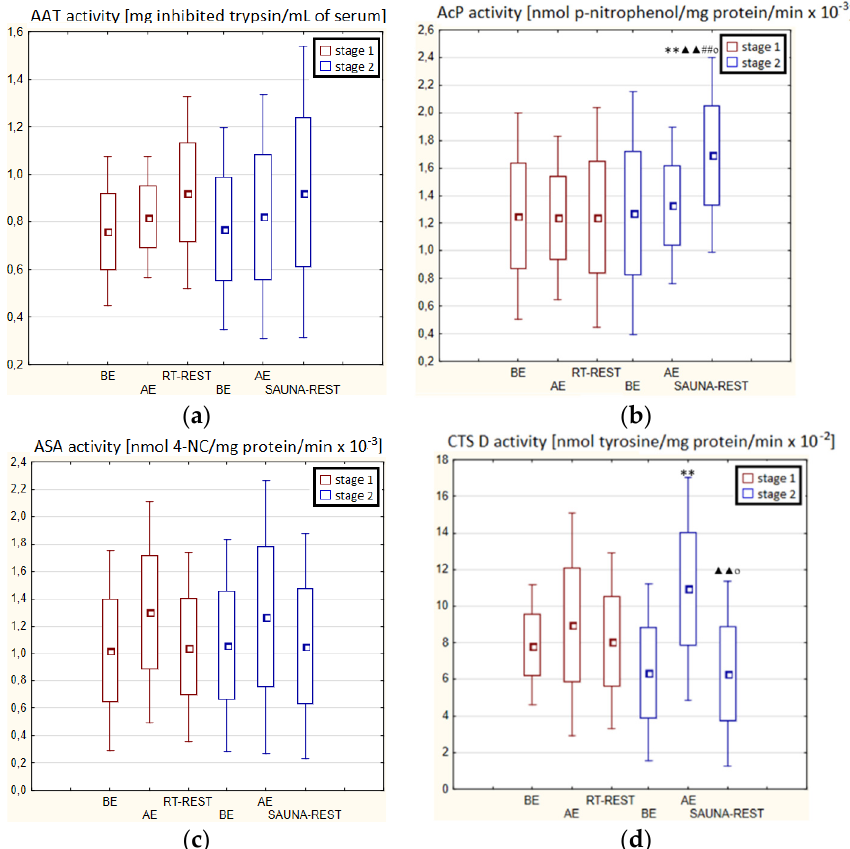
Figure 5. The activities of α 1-antytrypsin and lysosomal enzymes in blood serum of novices ( n = 23) in Experiment II: ( a ) AAT activity; ( b ) AcP activity; ( c ) ASA activity; ( d ) CTS D activity. Data are pre- sented as the mean values ± SD. AAT— α 1-antytrypsin, AcP—acid phosphatase, ASA—arylsulfatase, CTS D—cathepsin D, BE—before exercise, AF—after exercise, RT-REST—20-min recovery at room temperature, SAUNA-REST—rest combined with sauna bath, ** p < 0.001 vs. BE, ## p < 0.001 vs. RT-REST, o p < 0.05 vs.